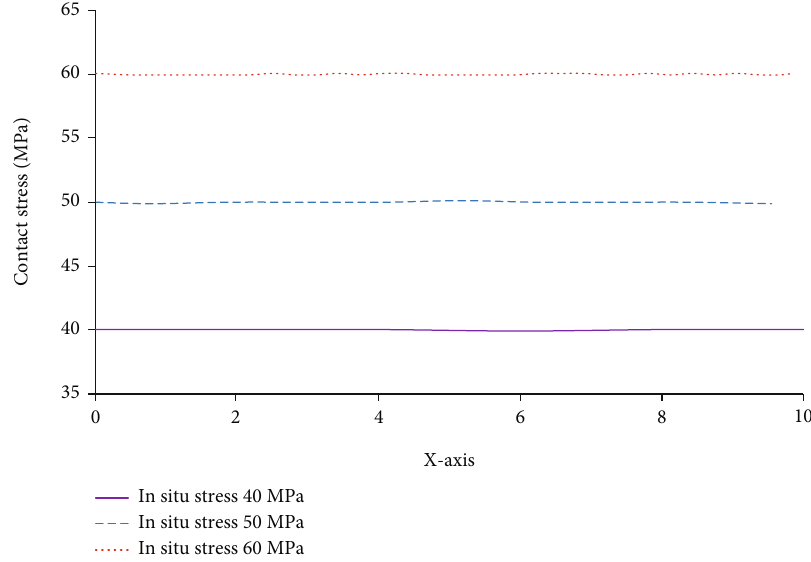
Figure 26: Comparison diagram of rock slab contact stress under di ff erent crustal stresses (elastic modulus 40